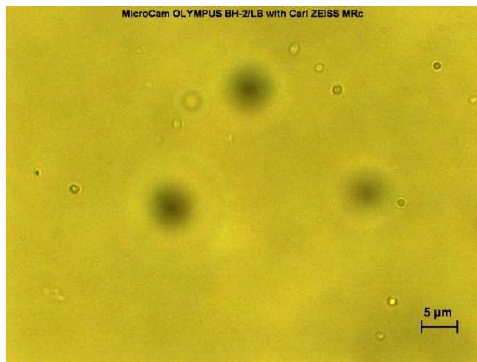
Figure 2. Microfluidic-prepared empty niosomes comprised of Span® 60, cholesterol, and Cremophor® ELP.